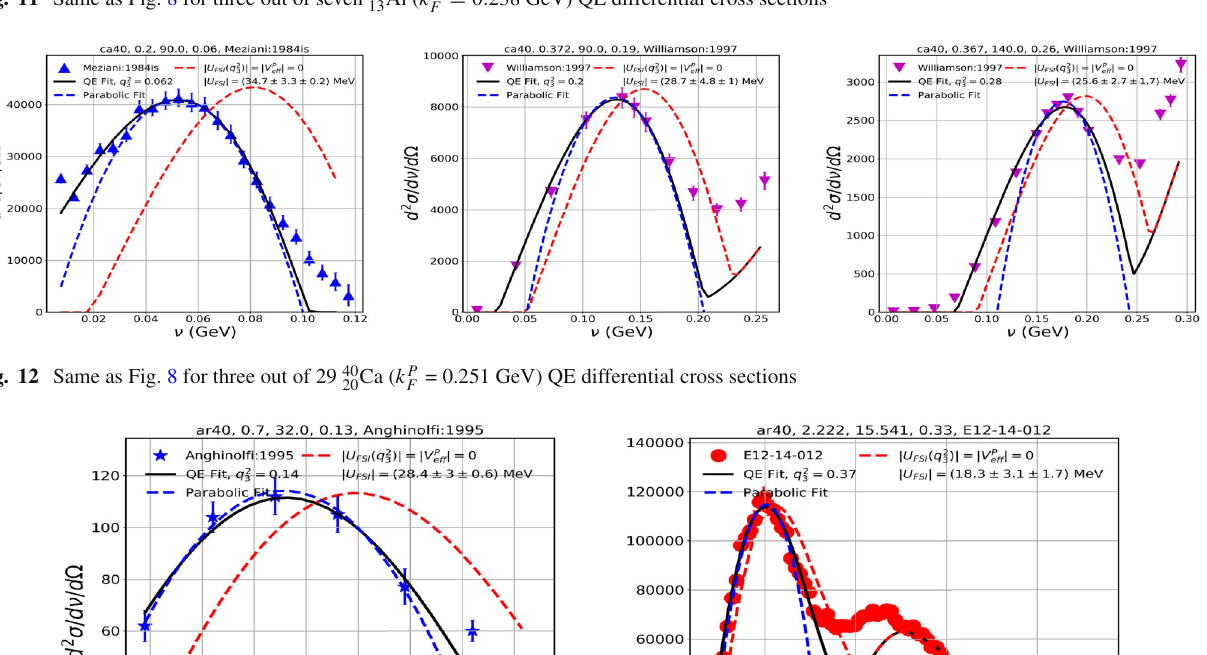
Fig. 13 Same as Fig. 8 for two 40